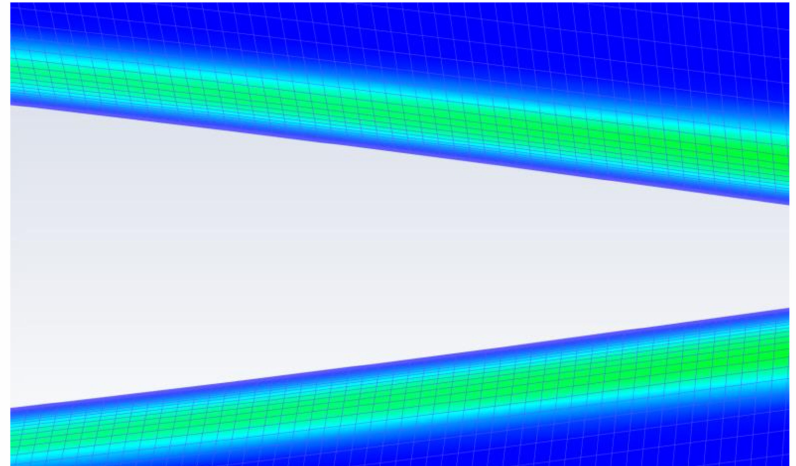
Figure 3. The TVR plot with y + value of 0.5.